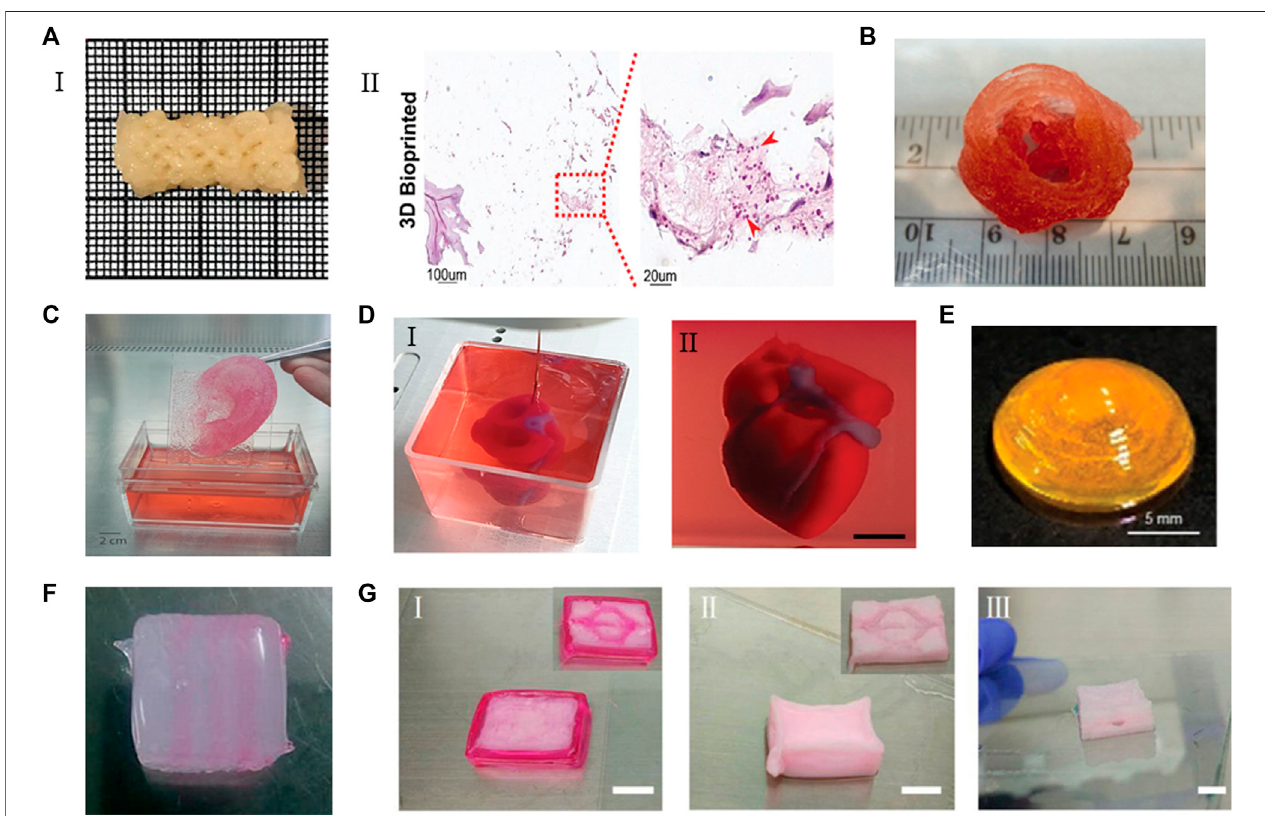
FIGURE 5 | The applications of ECM-based bioinks. (A) (I) A clavicle bone scaffold bioprinted with BPs GelMA-based bioink. (II) The scaffold stained for H&Eafter 28 days, the number of cells increased. Adapted with permission from (Ratheesh et al., 2020). (B) The aortic valve conduit bioprinted with bioink containing alginate/ gelatin hydrogel and aortic root sinus smooth muscle cells and aortic valve lea fl et interstitial cells. Adapted with permission from (Duan et al., 2013). (C) Adult size ears (8 cm) printed with bioink containing bovine gelatin/alginate/ fi brinogen and human fi broblasts. Adapted with permission from (Pourchet et al., 2017). (D) A heart printedwithbioinkcontainingdECMandiPSCs-derivedcardoimyocytesandECs.Adaptedwithpermissionfrom(Nooretal.,2019). (E) Thecurvedcorneabasedonthe eyeballprintedwithdECM-basedbioink.Adaptedwithpermissionfrom(KimH.etal.,2021). (F) Themultilevelvascularstructures,and (G) multibranchvascularchannels printed with bioink containing dECM/Pluronic F127 and endothelial cells. Adapted with permission from © 2018 by the (Xu et al., 2018). Licensee MDPI, Basel, Switzerland.